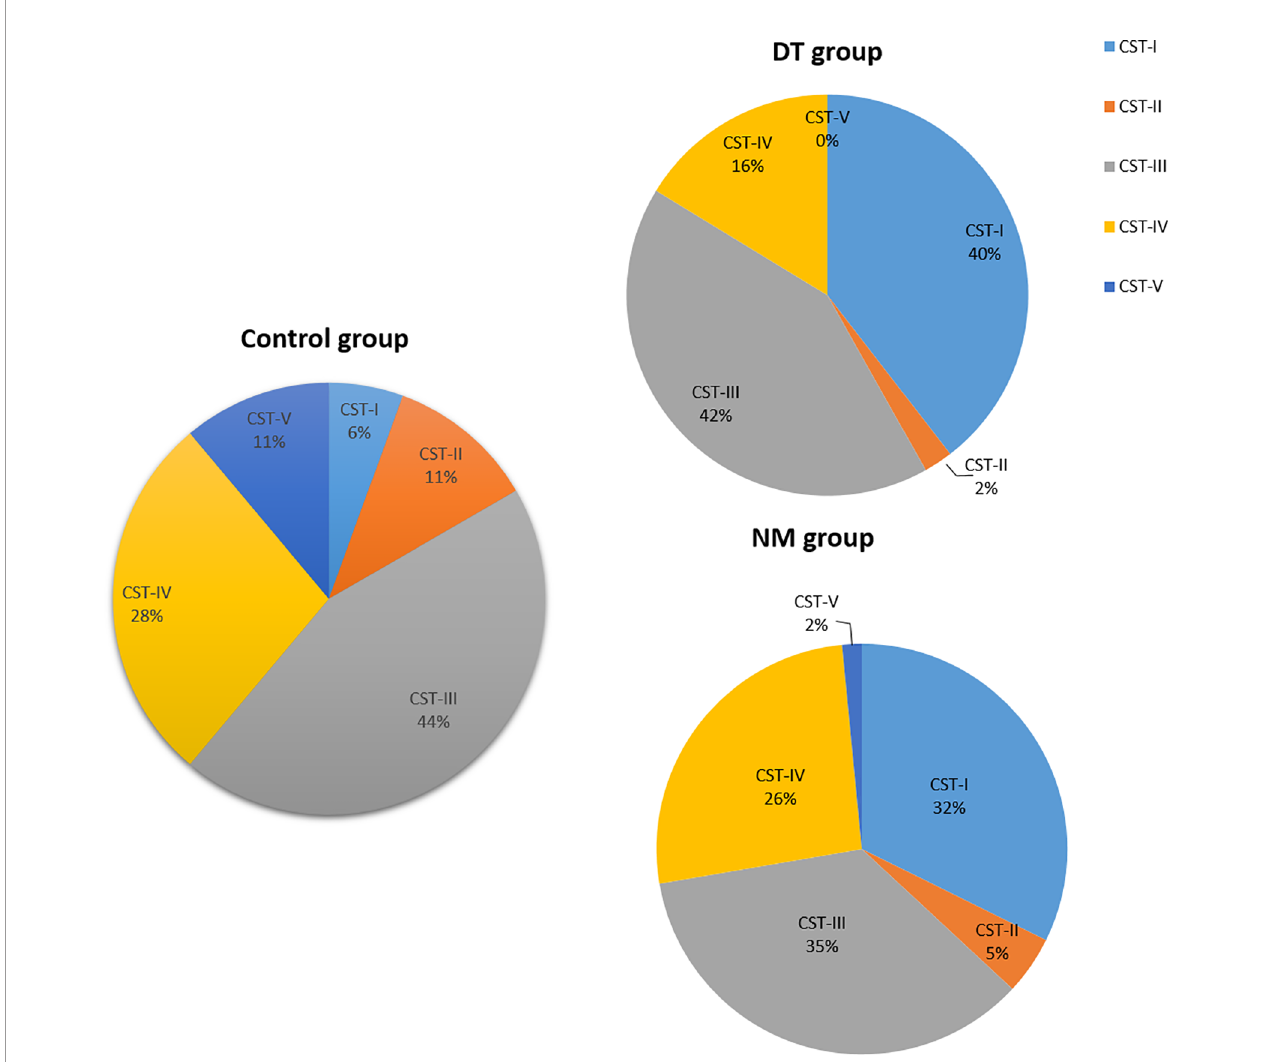
FIGURE 5 | The proportion of the Community State Types (CSTs) in each group; NM group ( n = 65), DT group ( n = 43), control group ( n